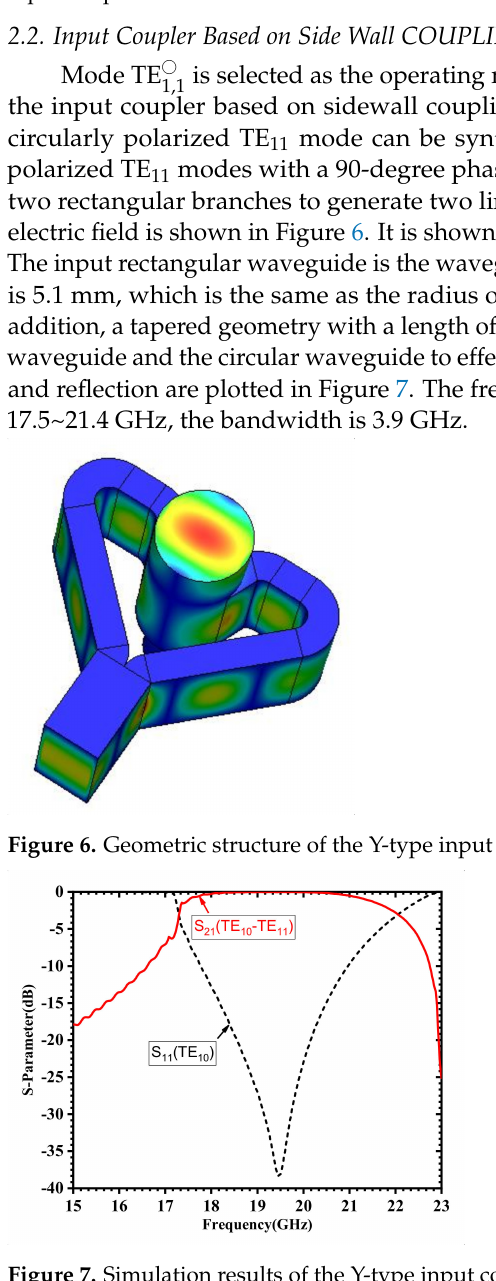
Figure 7. Simulation results of the Y-type input